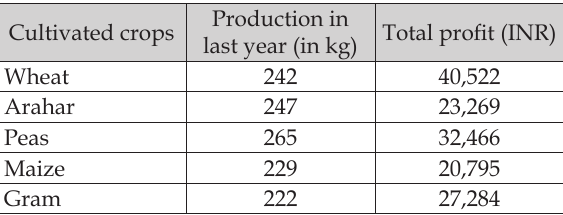
Table 10. Total valuation of cultivated